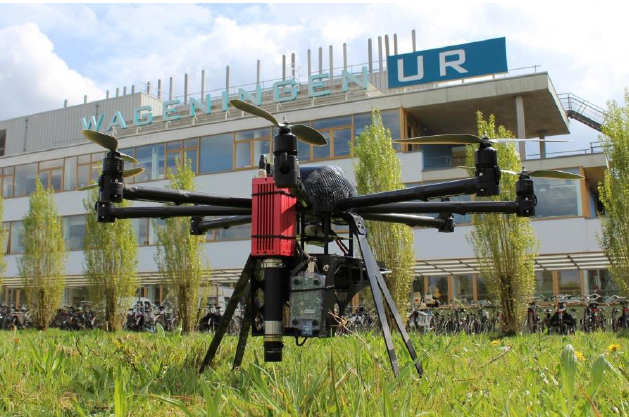
Figure 1. The WageningenUR HYMSY mounted under an Altura AT8 octocopter